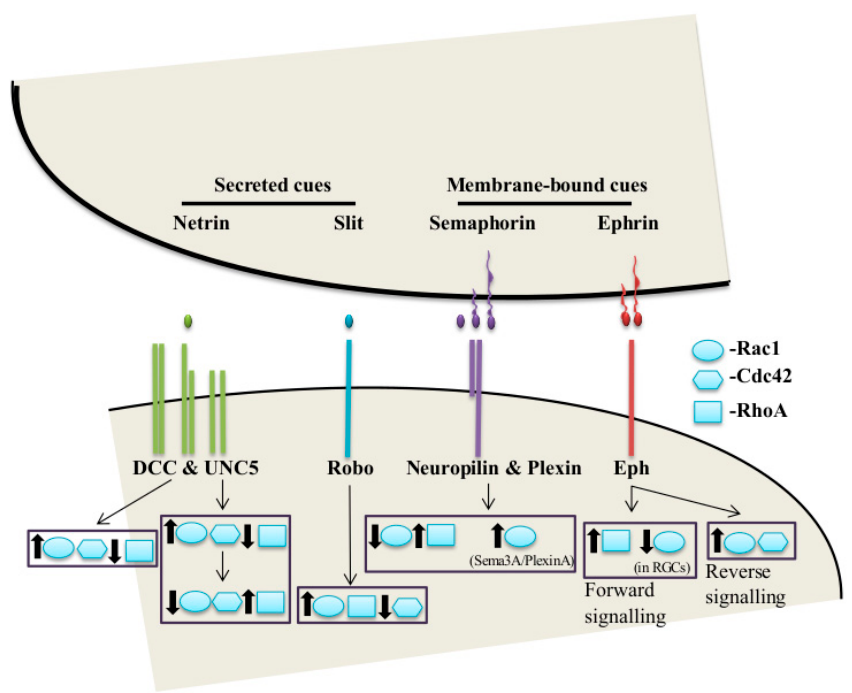
Figure 1. The classical guidance cues, their receptors, and their effect on Rho GTPases. A schematic representation of the up- or downregulation (bold arrows) of RhoA, Rac1, and Cdc42 by different guidance cue/receptor combinations.